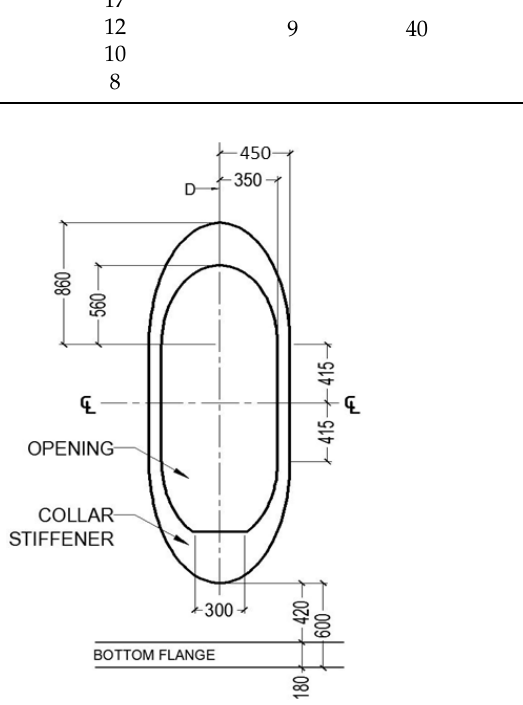
Figure 7. Collar stiffener and opening dimensions (unit: mm).